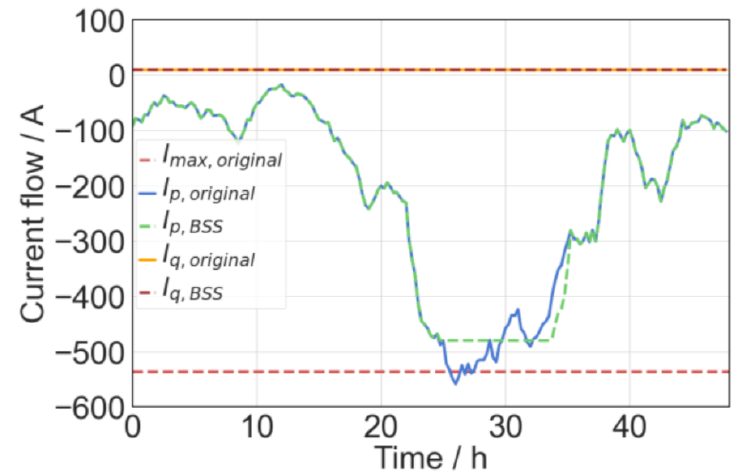
Figure 17. Current flow through line 6 before (blue trace) and after BSS application (green trace).